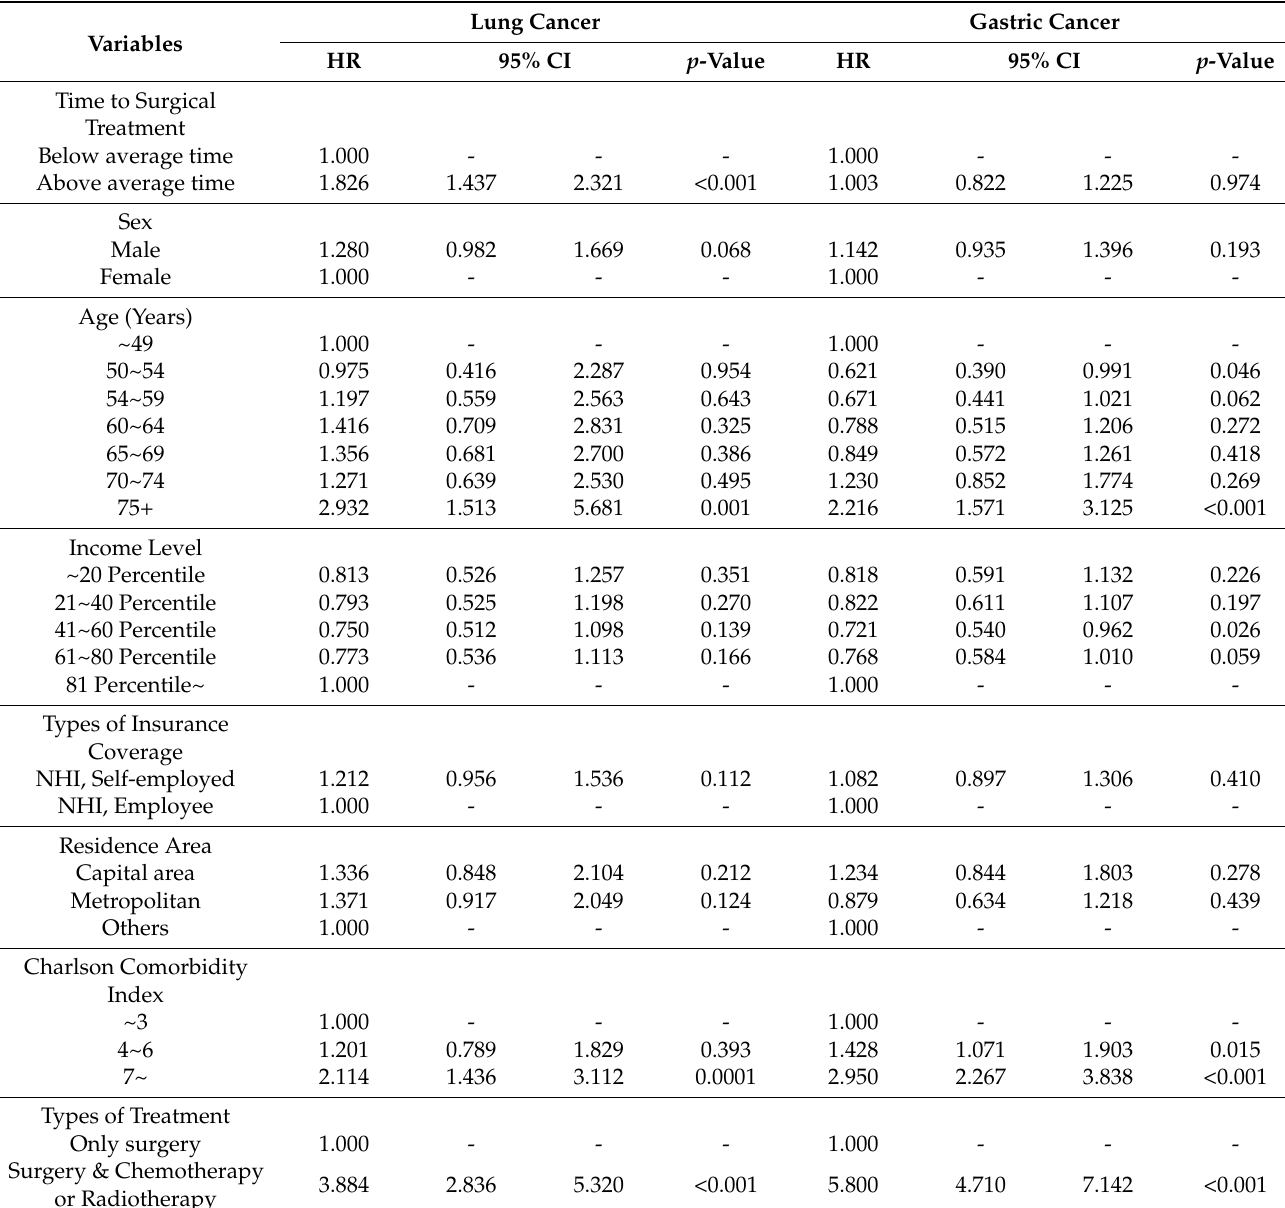
Table 2. Results of survival analysis by time to surgical